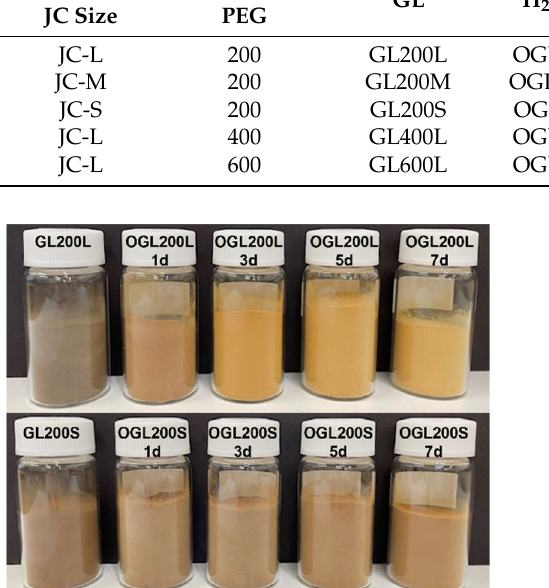
Figure 1. Illustration of OGLs (OGL200L11 and OGL200S11 series) after room-temperature H 2 O 2 - mediated oxidation treatment (GL200L and GL200S were prepared from the PEG200 solvolysis of JC wood meal L and S, respectively).